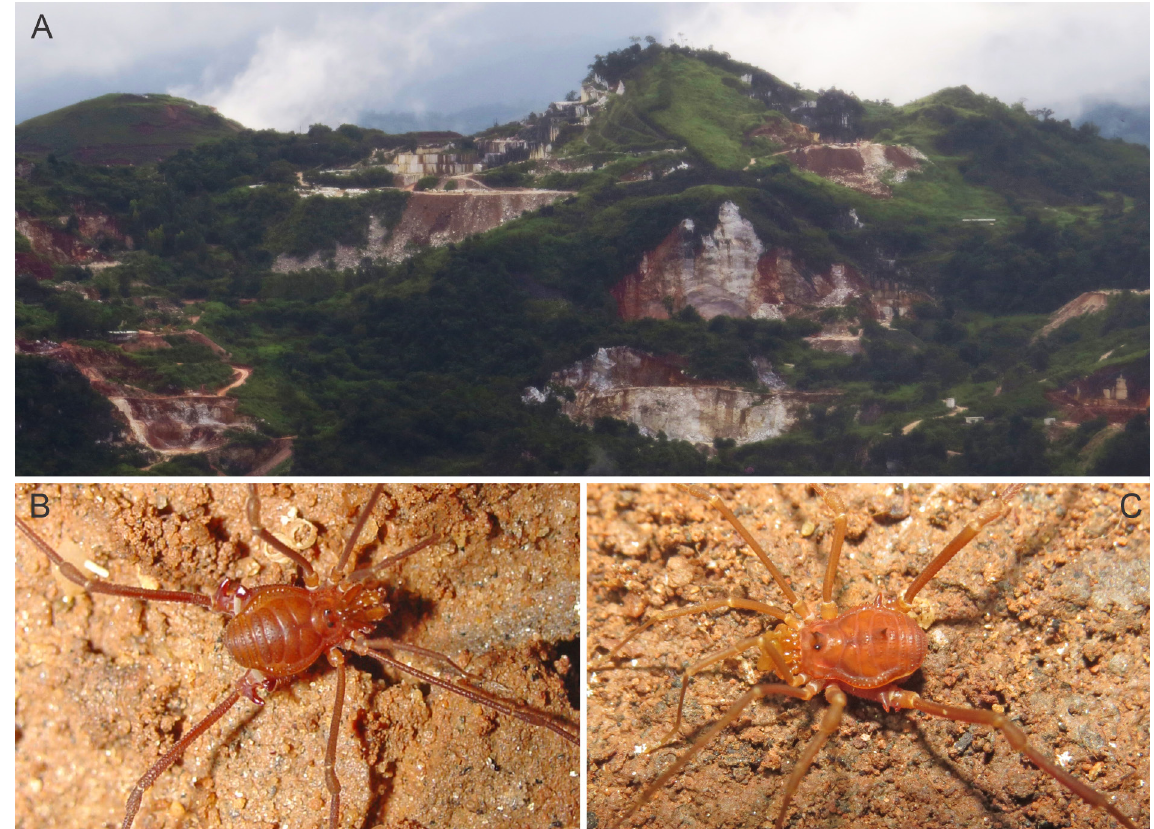
Fig. 10. A . External landscape of Vargem Alta Municipality, with many quarries for marble extraction. B . Living specimen of Eusarcus marmoreus sp. nov., ♂, holotype (ISLA 12968) from Caverna Archimides Panssini Cave, Vargem Alta Municipality, Espírito Santo State, Brazil. C . Living specimen of Eusarcus xambioa sp. nov., ♂, holotype (ISLA 60386) from Caverna da Explosão Cave, Xambioá Municipality, Tocantins State, Brazil. Photos by R.L.